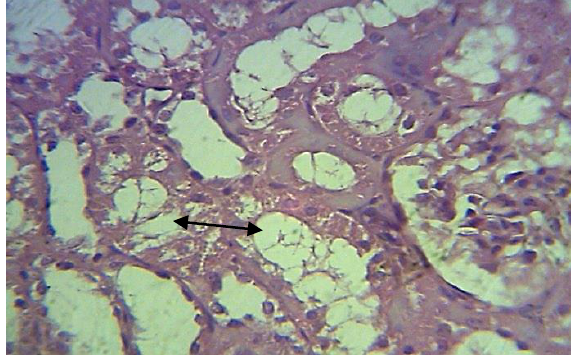
Fig. 6: Kidney of animal in T2 group 42 day day post treated with showed atrophy of glomerular tuft with dilatation of boman capsule and vacuolar degeneration of epithelial lining cells of renal tubules (H and E stain 40x).